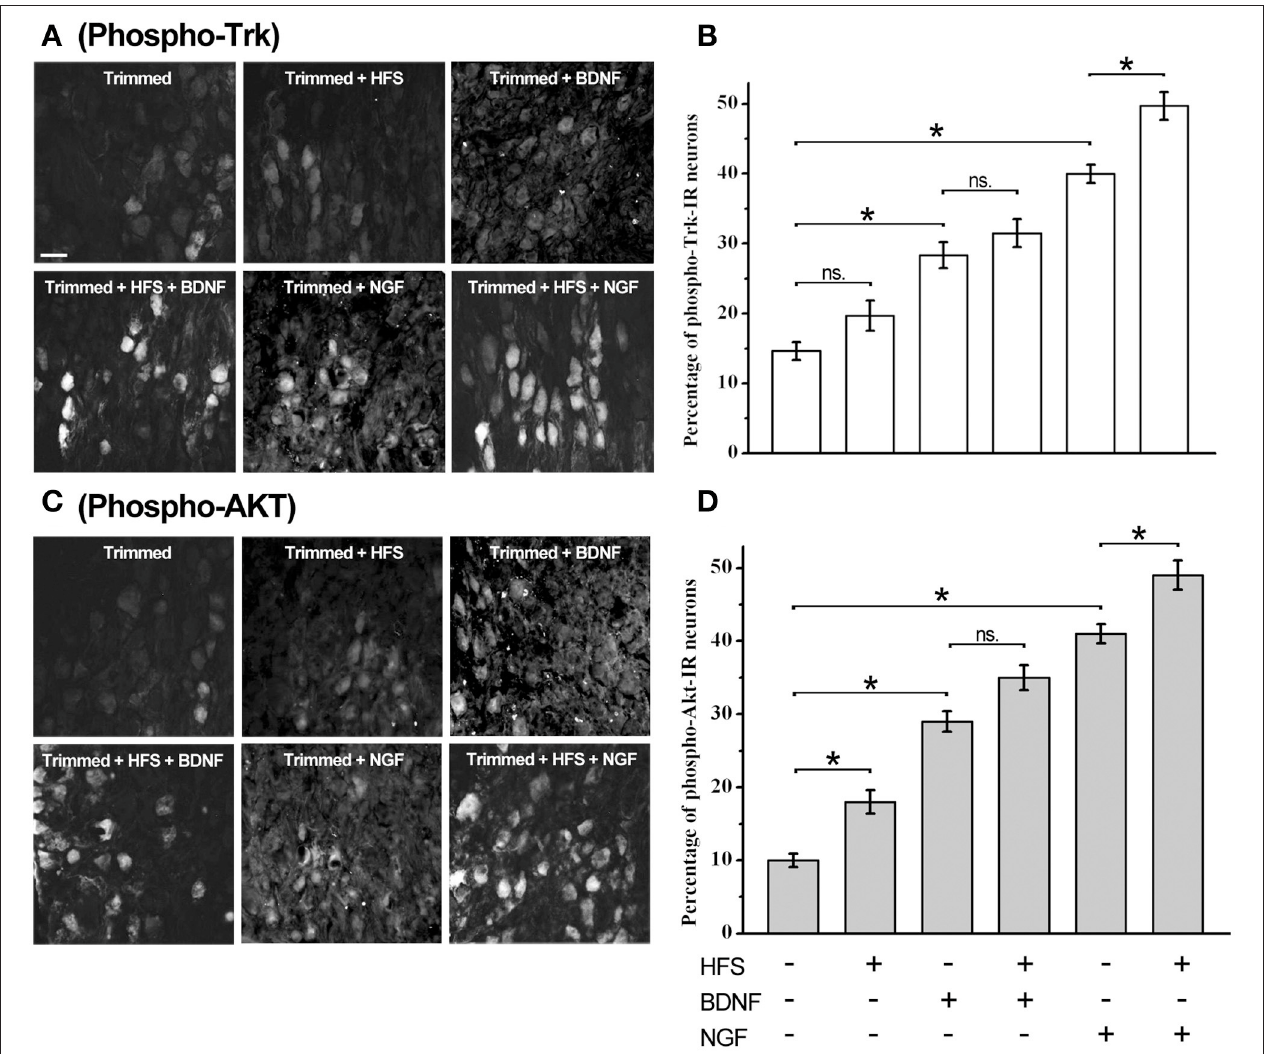
FIGURE 7 | Trk receptors are activated by electrical stimulation, BDNF, and NGF in sympathetic neurons. Examples of sympathetic neurons from adult trimmed SCG immunolabeled against phospho-Trk (A) and phospho-Akt (C) under different experimental conditions. Scale bar = 50 µ m. Bar graphs showing the averaged expression of phospho-Trk (B) and phospho-Akt (D) in the SCG, n = 4. Statistical analysis using one-way ANOVA and Sidak’s multiple comparison test showed that high frequency stimulation (HFS) trended to increase the level of phospho-Trk + ( p > 0.05), but increased significantly the proportion of phospho-Akt + cells from 10 ± 1 to 18 ± 2% ( p < 0.005). HFS in combination with BDNF did not produce significant changes either in phospho-Trk + or phospho-Akt + cells ( p > 0.05). In contrast, HFS in combination with NGF increased significantly the proportion of phospho-Trk + and phospho-Akt + cells, from 40 ± 1 to 50 ± 2% of phospho-Trk + cells ( p < 0.003), and from 41 ± 1 to 49 ± 2% of phospho-Akt + cells ( p < 0.004). Both neurotrophins increased significantly the proportion of phospho-Trk and phospho-Akt neurons. Thus, BDNF increased the proportion of phospho-Trk-IR and phospho-Akt + neurons from 15 ± 1 to 29 ± 2% and from 10 ± 1 to 29 ± 1%, respectively (